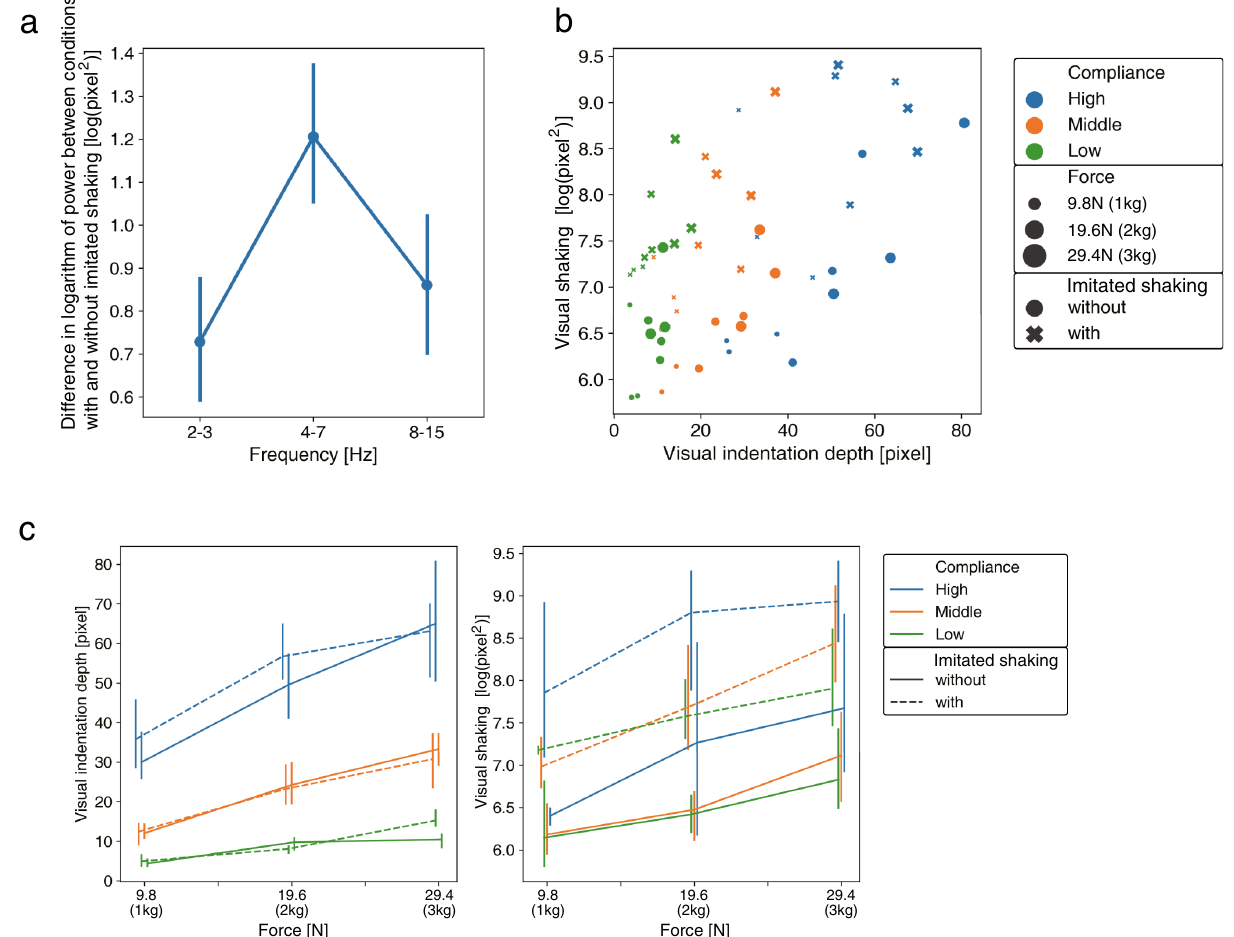
Figure 2. (a) Logarithm of power of optical flow vectors. Error bars denote 95%CI. (b) Visual features of each video clip. (c) Visual feature change for each stimulus factors. Error bars denote